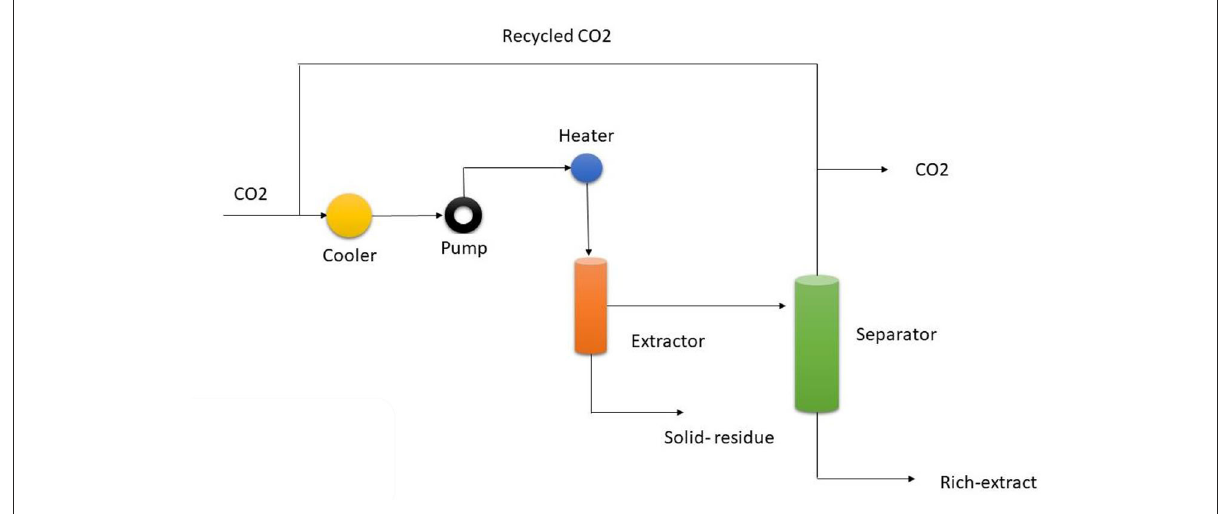
FIGURE8 Super critical fluid extraction